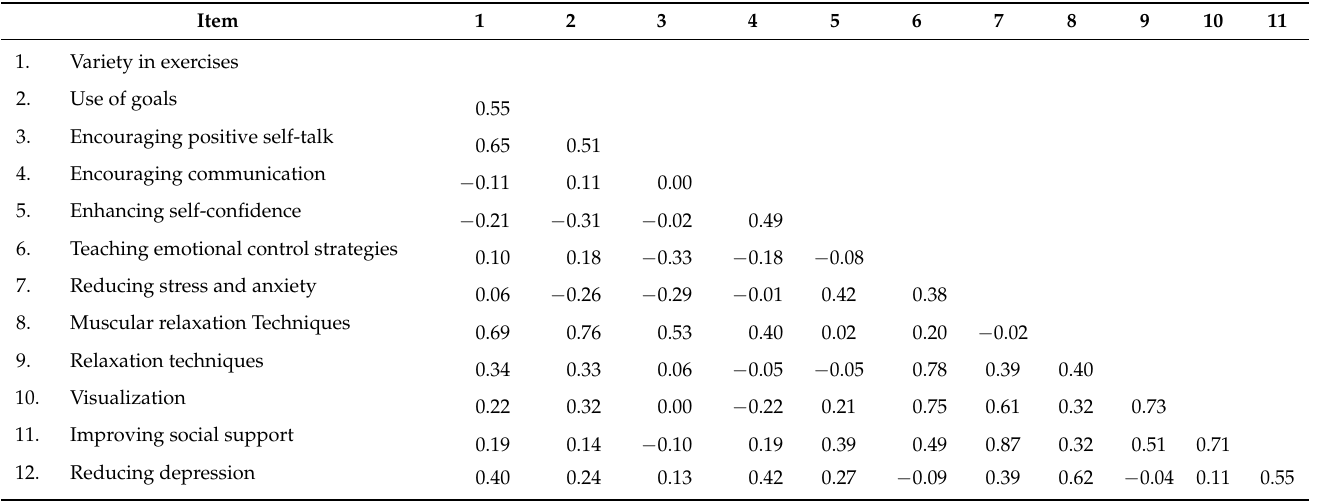
Table 2. Spearman correlations among responses to Physiotherapists and Sport Psychology Ques- tionnaire items.